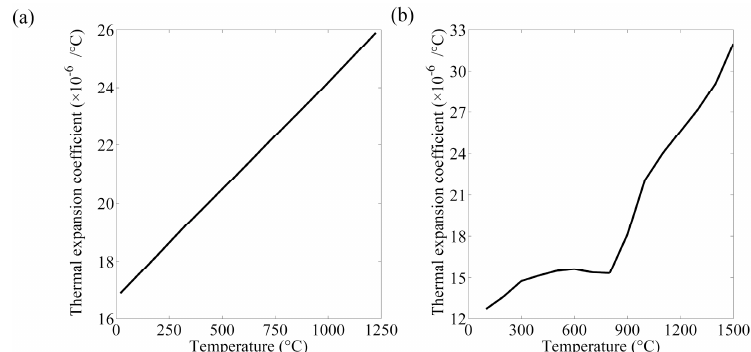
Figure 7. Thermal expansion coefficient of the electrode ( a ) and DP600 ( b ).